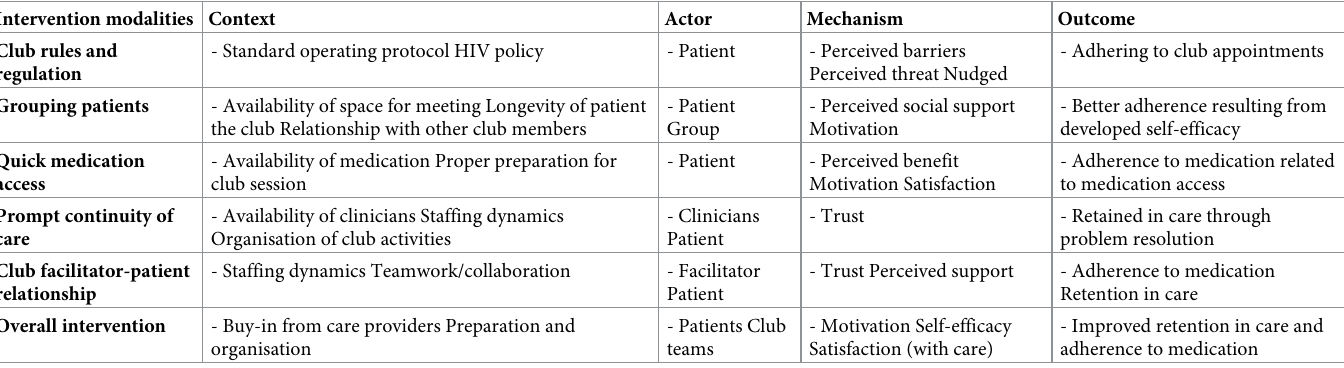
Table 7. Adherence club intervention-context-actor-mechanism-outcome